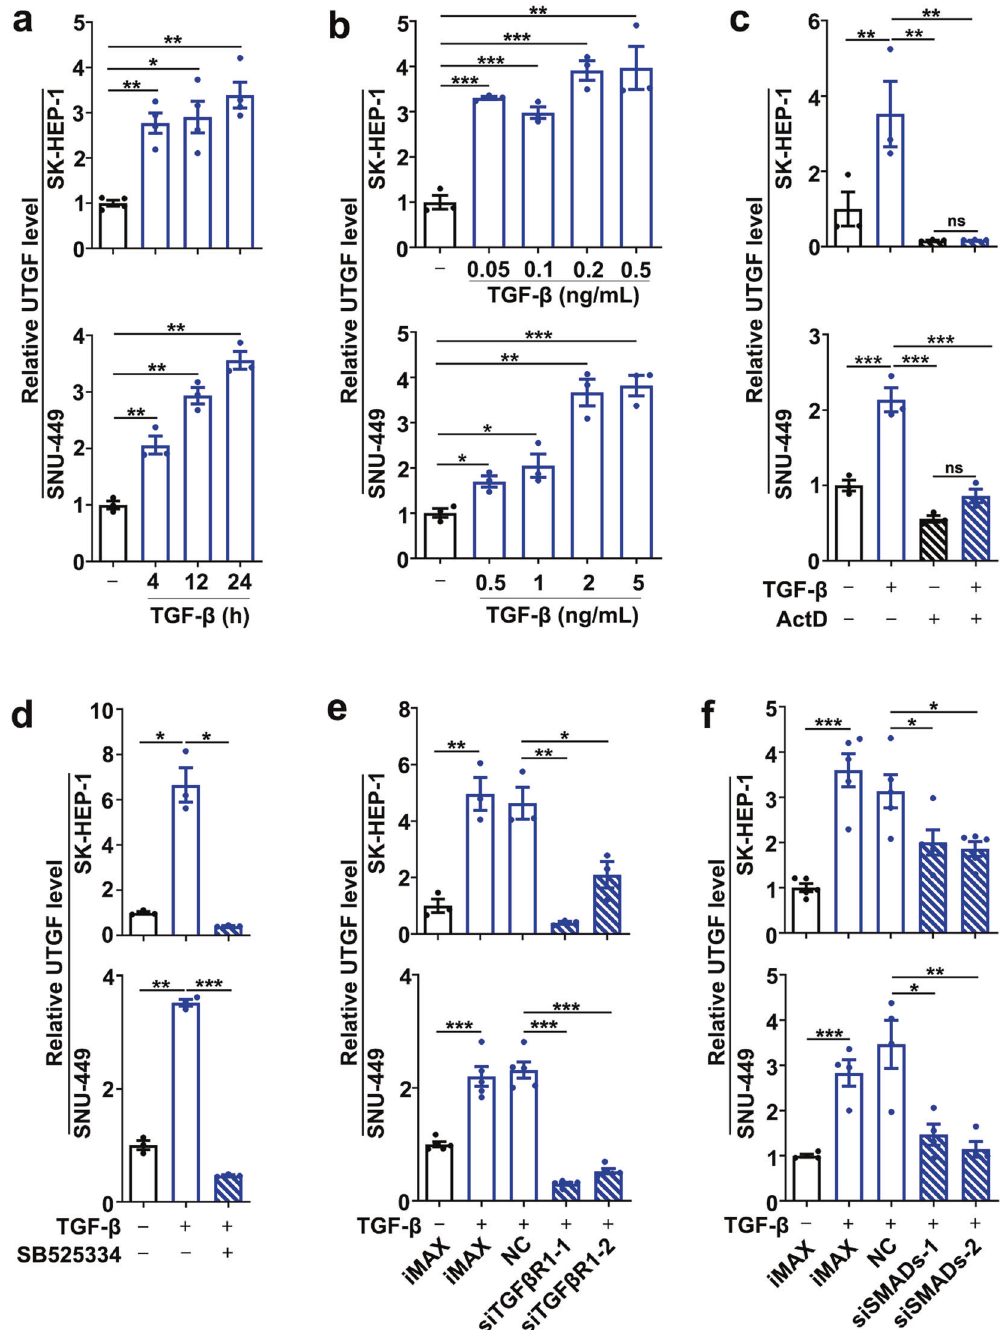
Fig. 1 TGF- β activates lnc-UTGF transcription via the canonical TGF- β /SMAD signaling pathway. a , b TGF- β increased lnc-UTGF level in a time- and dose-dependent manner. SK-HEP-1 or SNU-449 cells were untreated (-) or treated with 2 ng/ml TGF- β for the indicated time ( a ) or with the indicated dose of TGF- β for 24 h ( b ). c Treatment with transcription inhibitor abolished the TGF- β -induced lnc-UTGF expression. Cells were incubated without or with TGF- β or actinomycin-D (ActD) for 6 h. d - f Inhibition of TGF β R1 or simultaneous knockdown of SMAD2/3/4 attenuated the TGF- β -induced lnc-UTGF expression. For d , cells were incubated without or with TGF- β or TGF β R1 inhibitor (SB525334) for 12 h. For e – f , cells transfected with the indicated RNA duplexes were incubated without or with TGF- β for 24 h. iMAX, cells treated with Lipofectamine RNAiMAX without RNA duplexes. NC, cells transfected with negative control RNA duplex. siTGF β R1-1 and siTGF β R1-2, cells transfected with siRNA targeting different sequences of TGF β R1. siSMADs-1 and siSMADs-2, cells transfected with the mixture of siRNAs targeting SMAD2, SMAD3, and SMAD4. Lnc-UTGF level was detected by qPCR analysis, and U6 was used as an internal control. + or − , cells with ( + ) or without ( − ) the indicated treatment. Error bars: SEM from at least three independent experiments. *, P < 0.05; **, P < 0.01; ***, P < 0.001; ns, not signi fi cant